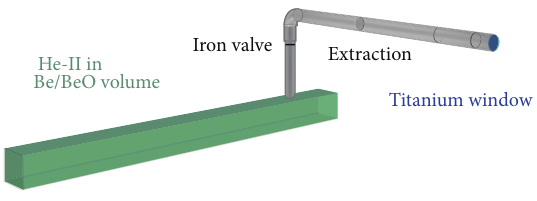
Figure 20: Geometry described and used in the simulation. Extra-shielding will be added to the installation in order to reduce this background.